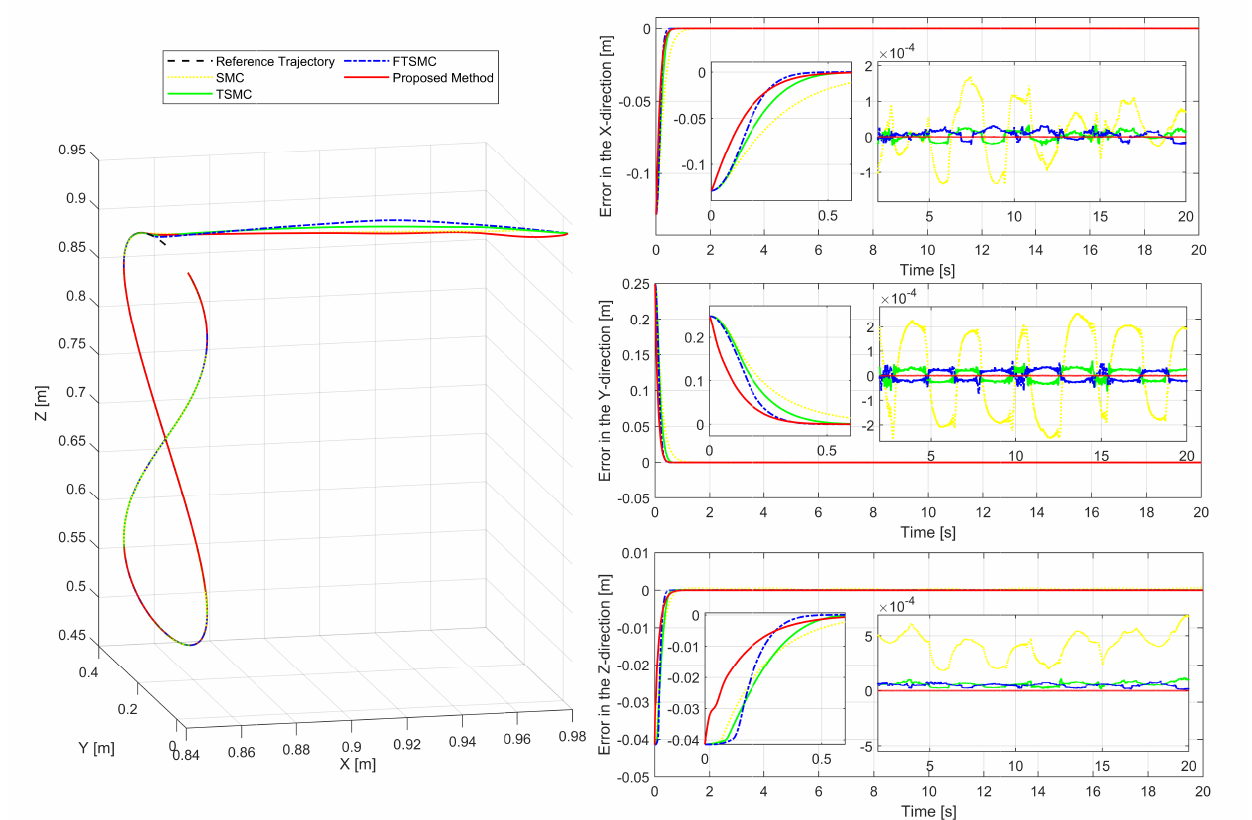
Figure 12. Performance of the control system in tracking another